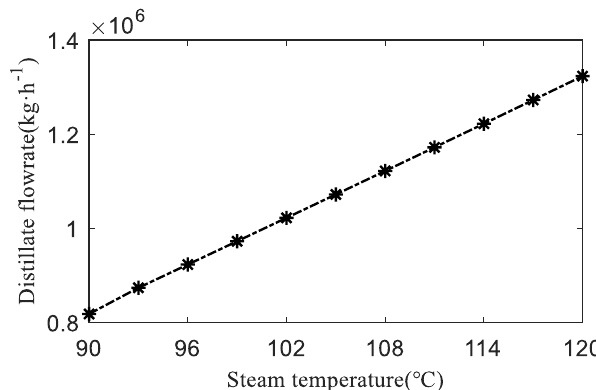
Figure 9. Effect of steam temperature ( steam T ) on distillate flowrate ( DN W ).